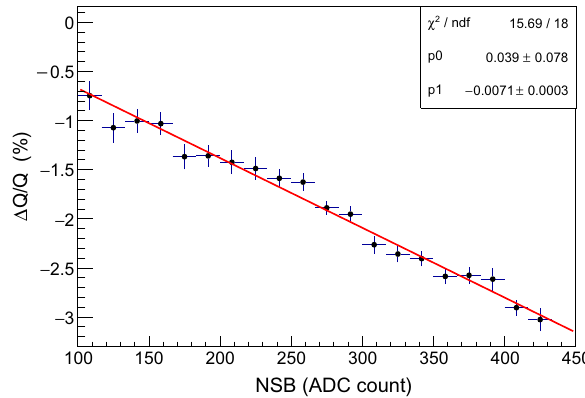
Fig. 22 The SiPM relative response charge varies as function of the NSB. As expected, the response charge decreases with increasing NSB because of the SiPM output charge drop introduced by the bias resistor, additional heat and recharging process in the SiPM. The slope is about − 0.71% per 100 ADC